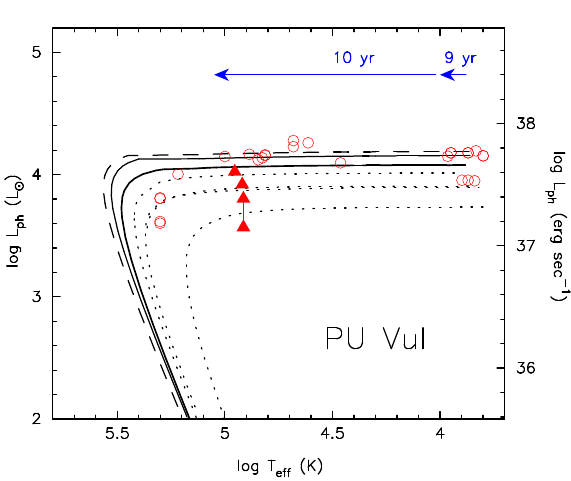
Fig. 3. Evolution of PU Vul in the HR diagram. Circles and triangles are our obser- vational estimates. Lines denote theoretical models. Two solid lines indicate the models of 0.6 M ⊙ WD with different composition: X = 0 : 5 and Z = 0 : 01 (the upper solid line) and with X = 0 : 7 and Z = 0 : 01 (the lower solid line). Dashed line denotes a 0.7 M ⊙ WD with X = 0 : 7 and Z = 0 : 01. Four dotted lines denote 0.5 M ⊙ WD models with different chemical compositions and radii: the upper is for X = 0 : 5 and Z = 0 : 02, the two next almost overlapping lines are for X = 0 : 7 and Z = 0 : 01 (upper) and X = 0 : 7 and Z = 0 : 02 (lower), and the lowest line is for a WD with X = 0 : 7 and Z = 0 : 02 and a larger radius. The arrows indicate evolution time scales of 0.6 M ⊙ WD with X = 0 : 7 and Z = 0 : 01 – from the beginning of the flat peak to log T (K) = 4.0, and from log T (K) = 4.0 to